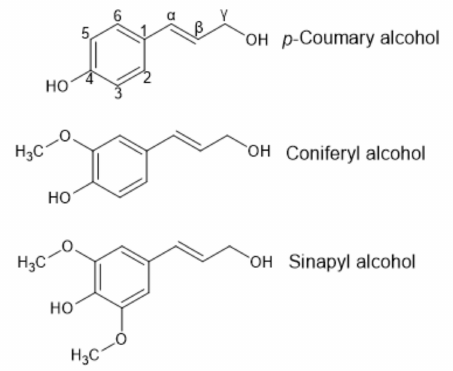
Figure 1. Structures of the three occurring monolignols in lignin.